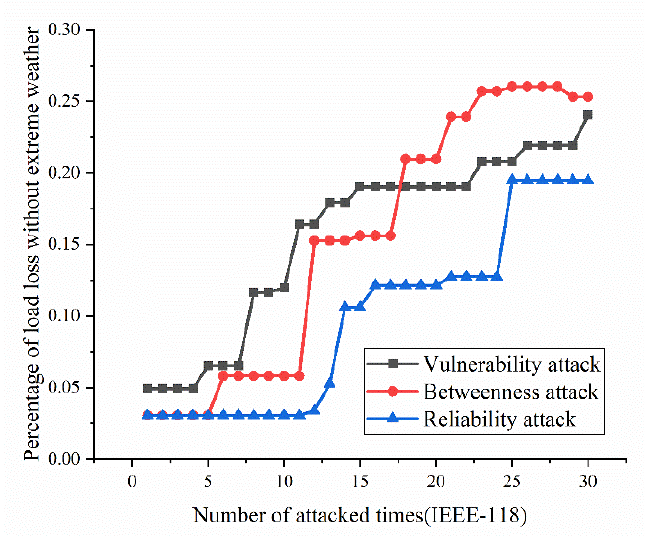
Figure 18. Variation ratio of network transmission efficiency of IEEE-30 bus system without extreme weather.